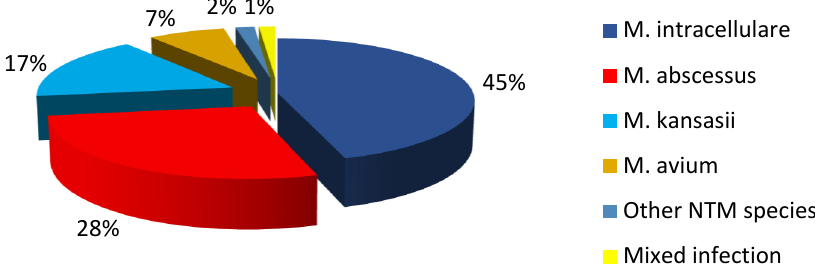
Figure 1. Distribution proportion of NTM pulmonary disease strains in the Yangtze River Delta.